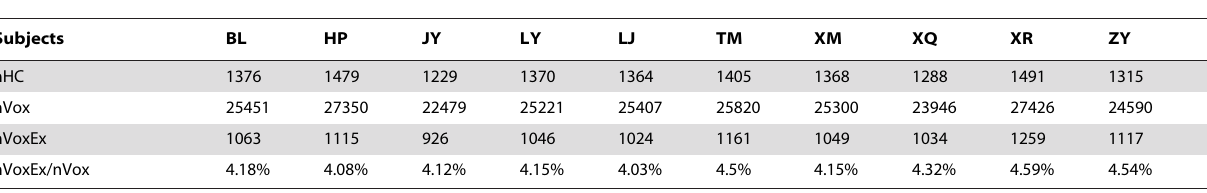
Table 1. Information on partition of homogenous clusters.